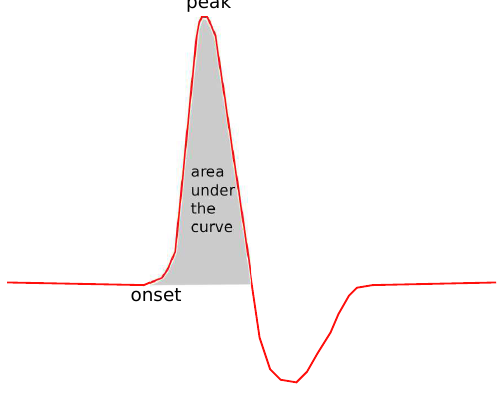
Figure 4. The area under the